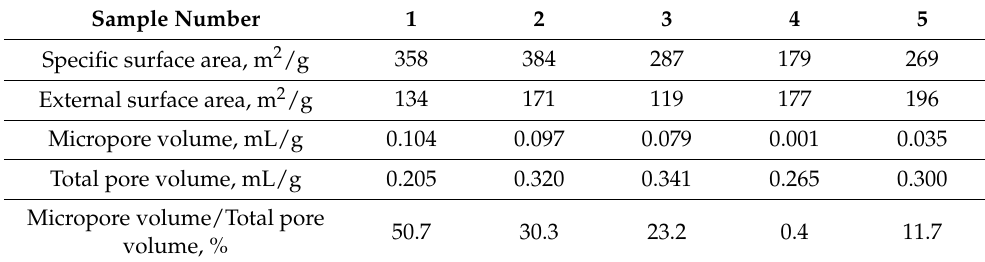
Table 1. Results of parameters of porous structure of samples.